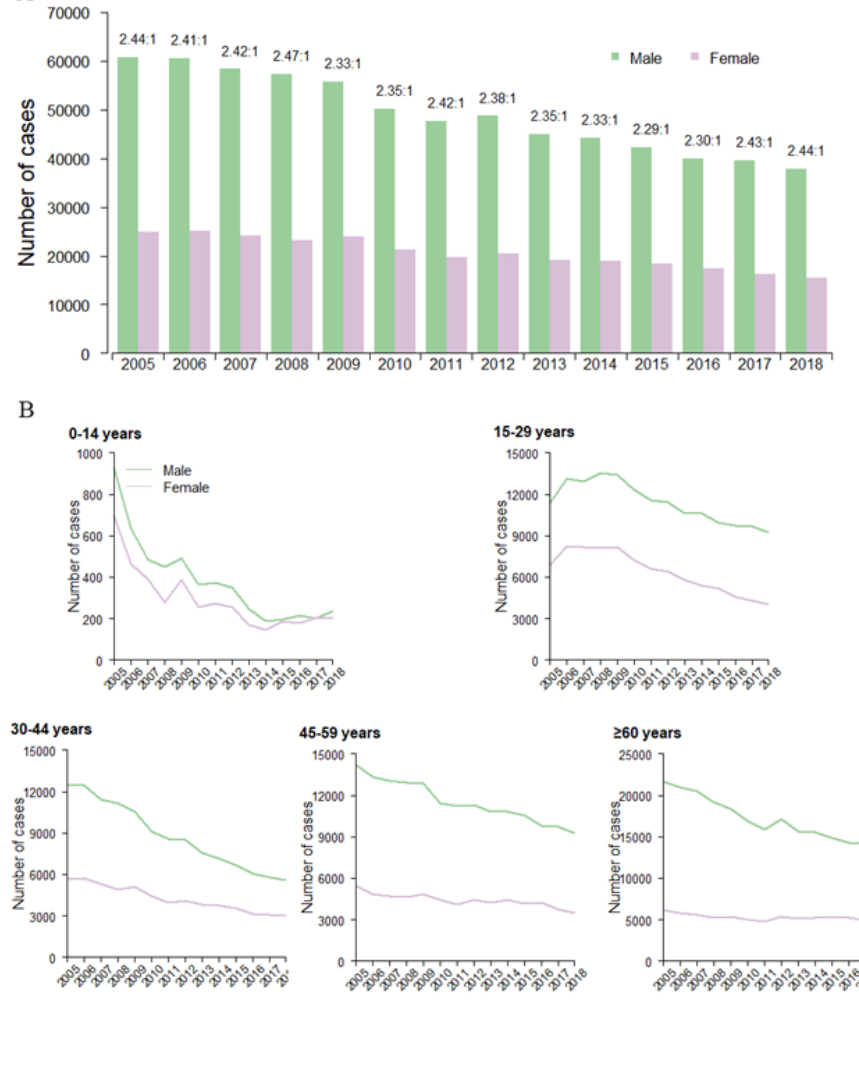
Figure 1. Number of pulmonary tuberculosis (PTB) cases by age and sex in Henan province, China, from 2005 to 2018. A: Number of PTB cases by sex and year. B: Number of PTB cases by age group, sex, and